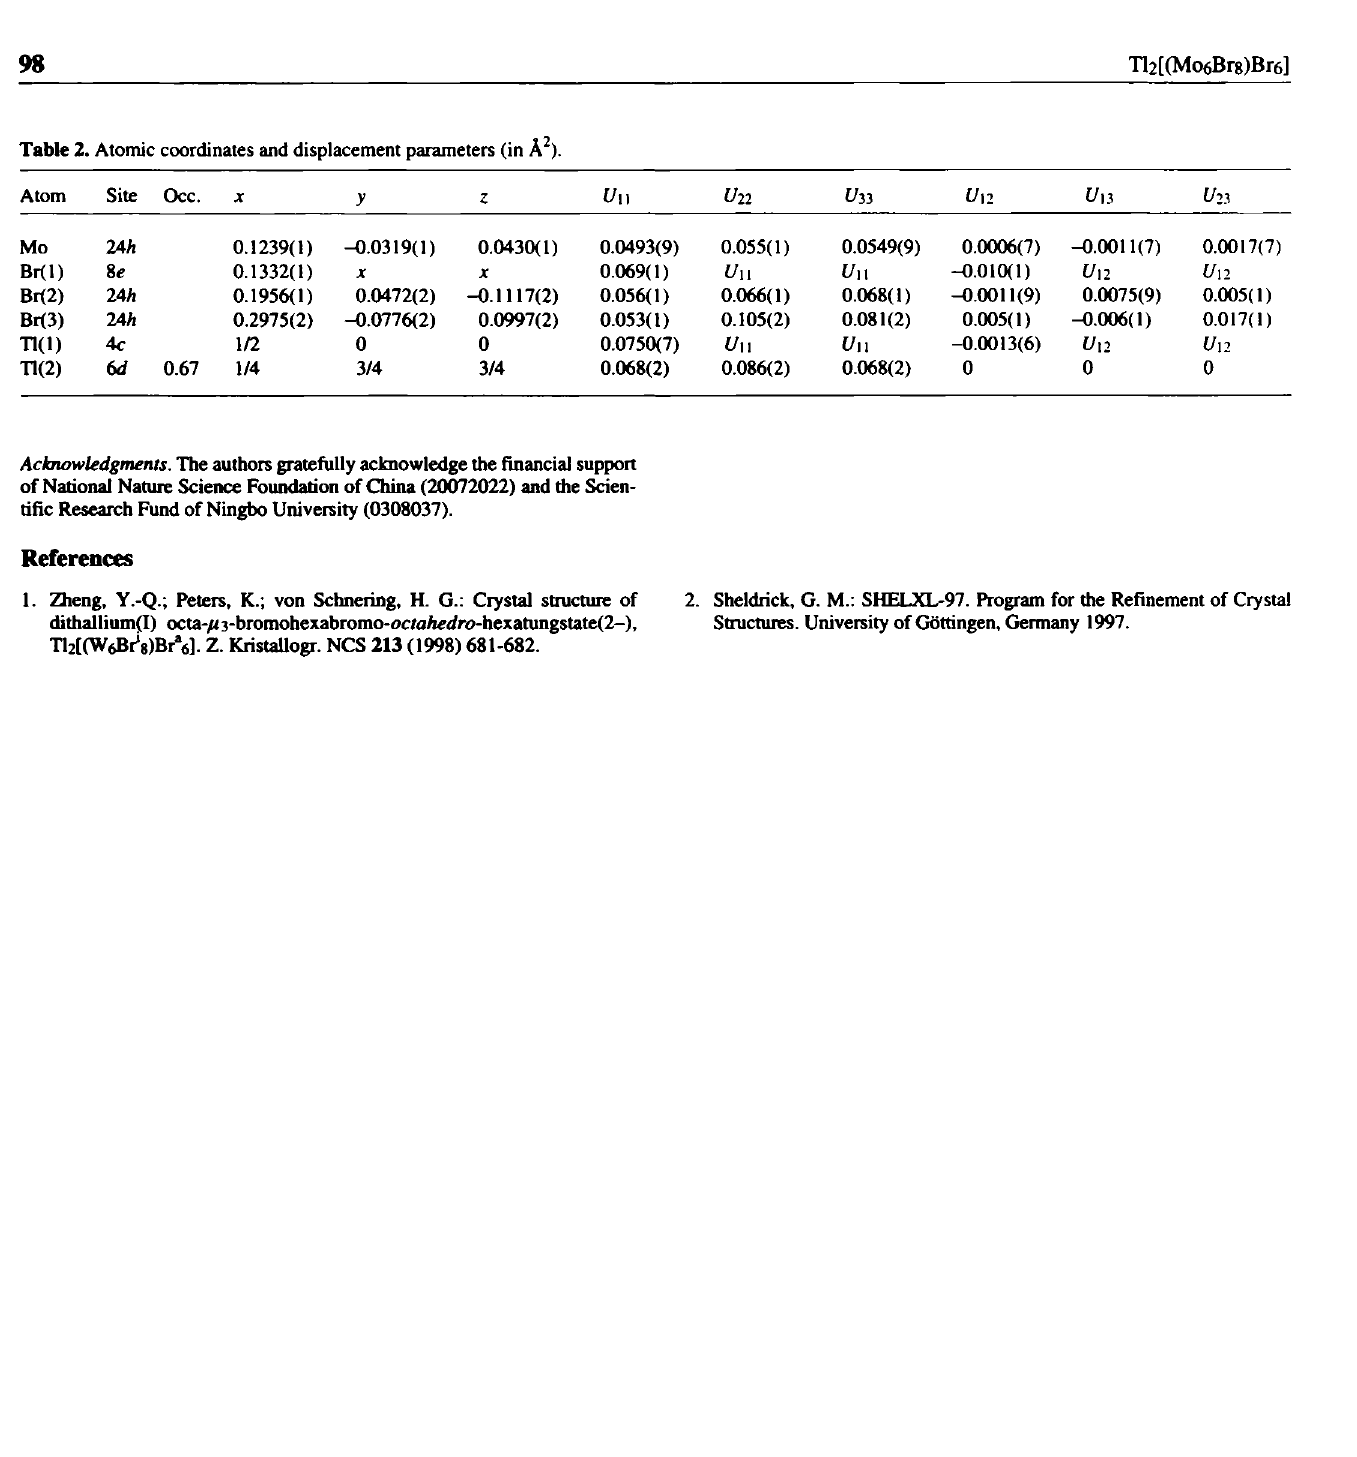
Table 2. Atomic coordinates and displacement parameters (in Â 2 ). Atom Site